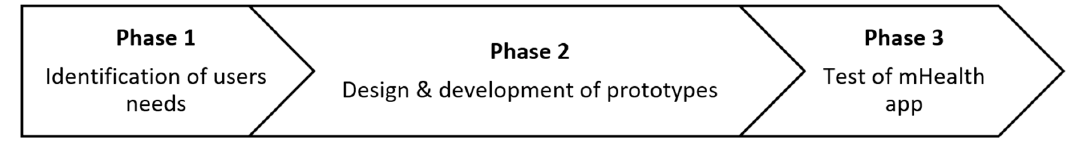
Figure 2. The participatory design process in the study.